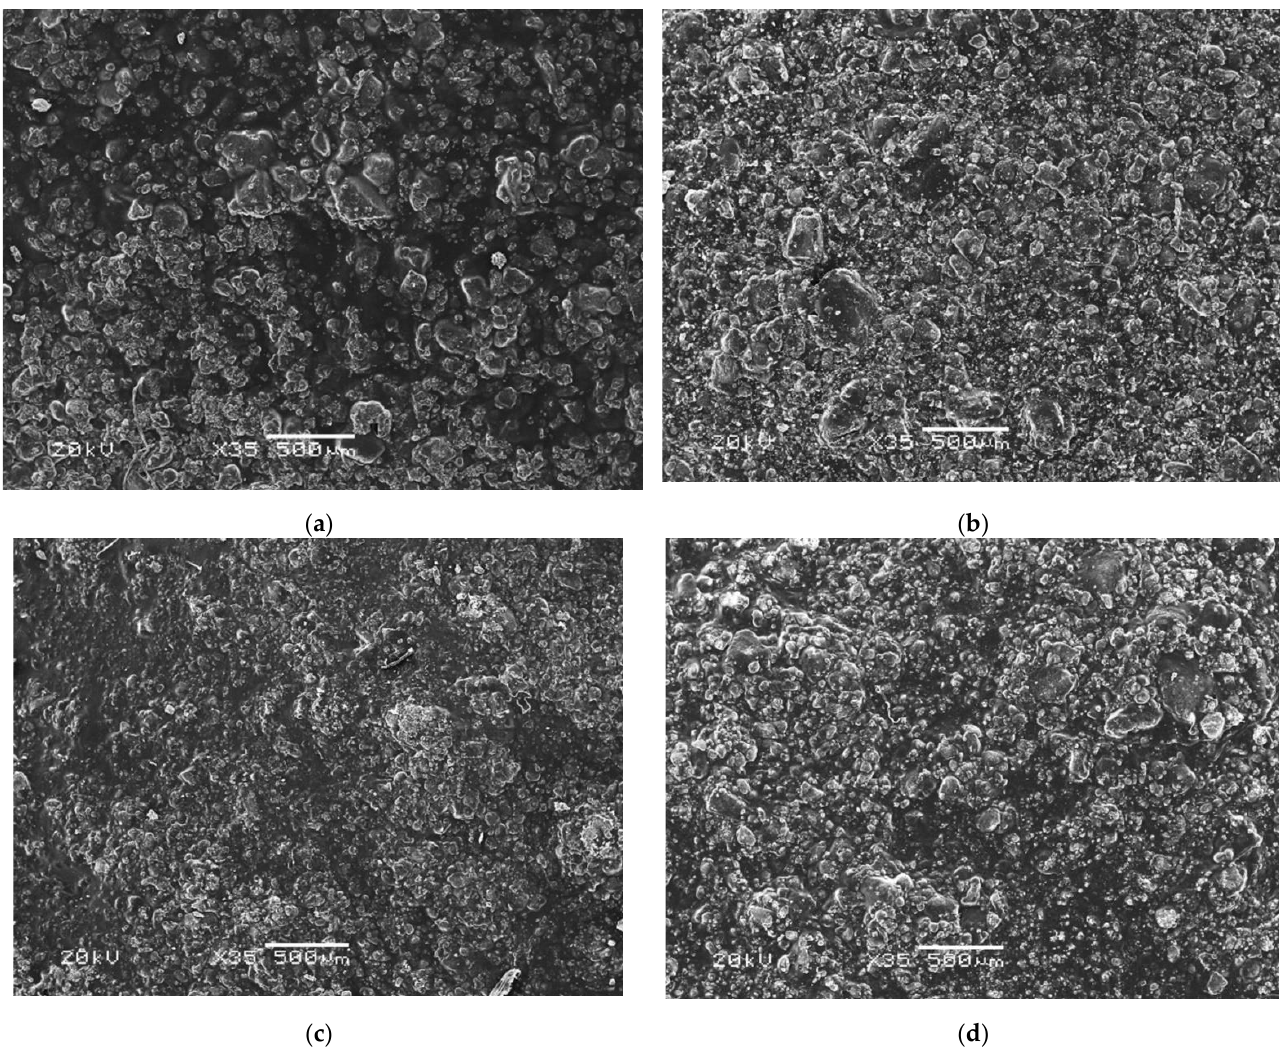
Figure 6. Morphology analysis of the composites ( a ) 17.2. before incubation; ( b ) 17.2 after incubation in PBS; ( c ) 25.2 before incubation; ( d ) 25.5 after incubation in PBS.